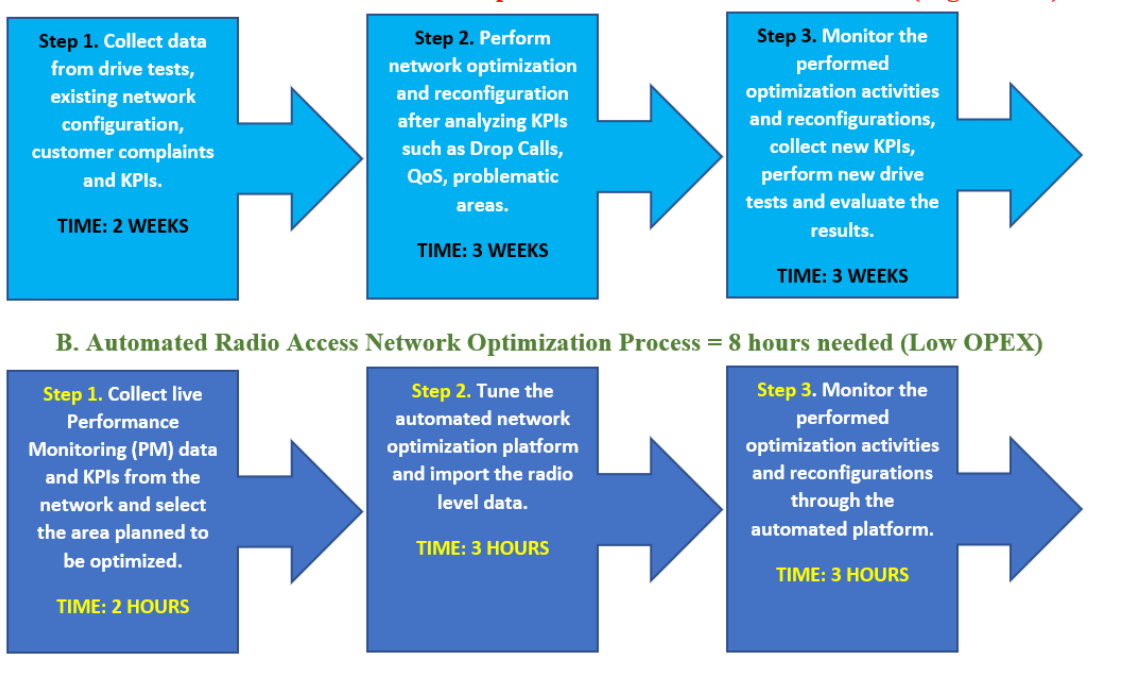
Figure 1. Traditional vs. automated optimization.